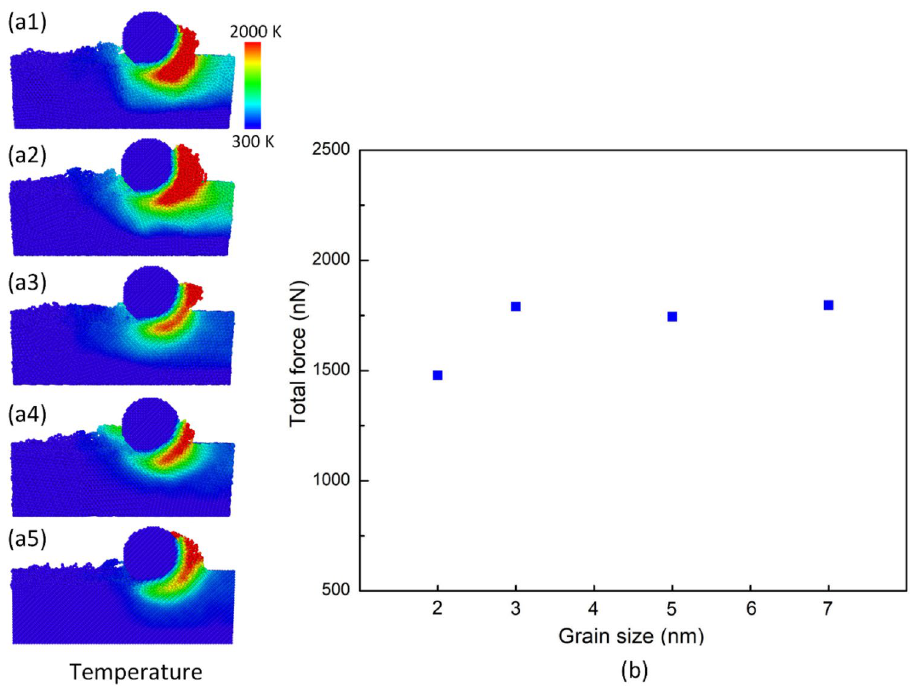
Figure 10. Temperature distribution and total force at different grain sizes at 300 K, 100 m/s, and 10 Å depth: ( a1 ) 2 nm, ( a2 ) 3 nm, ( a3 ) 5 nm, and ( a4 ) 7 nm; ( b ) the total force vs grain